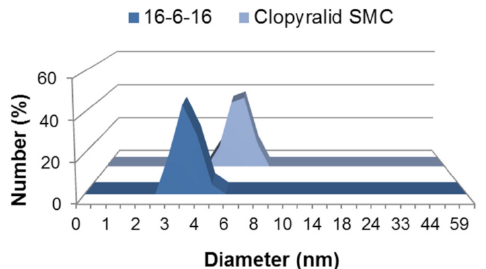
Figure 3. Hydrodynamic diameter of the 16-6-16 micelles in the presence and absence of clopyralid at 25 ◦